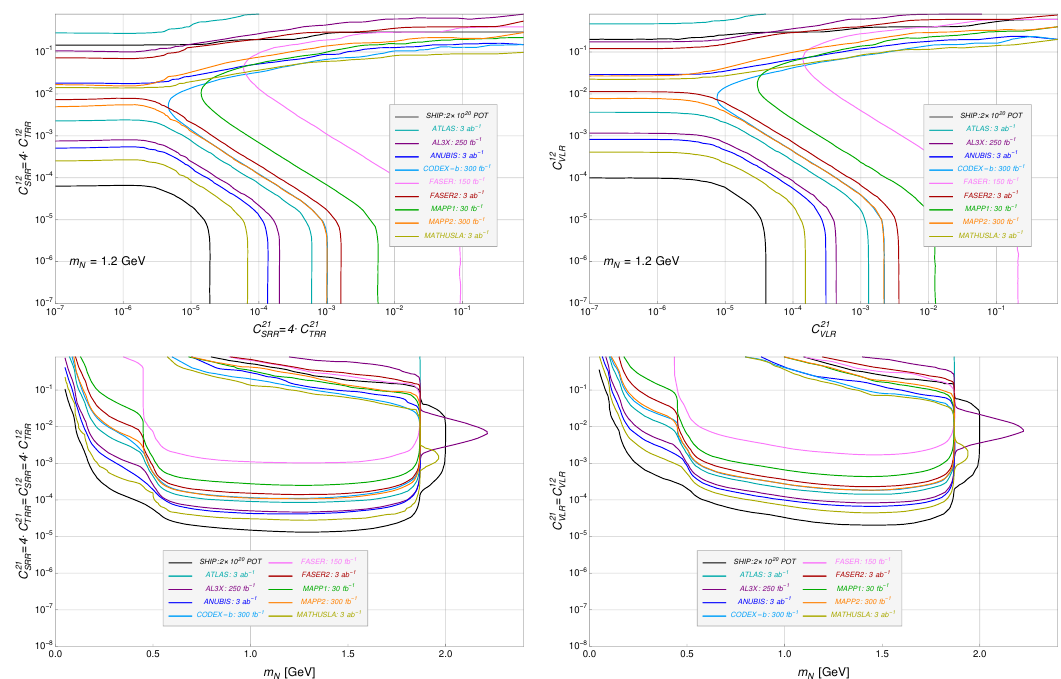
Figure 8 . Results for (cid:13)avor benchmark 2. The format is the same as in (cid:12)gure